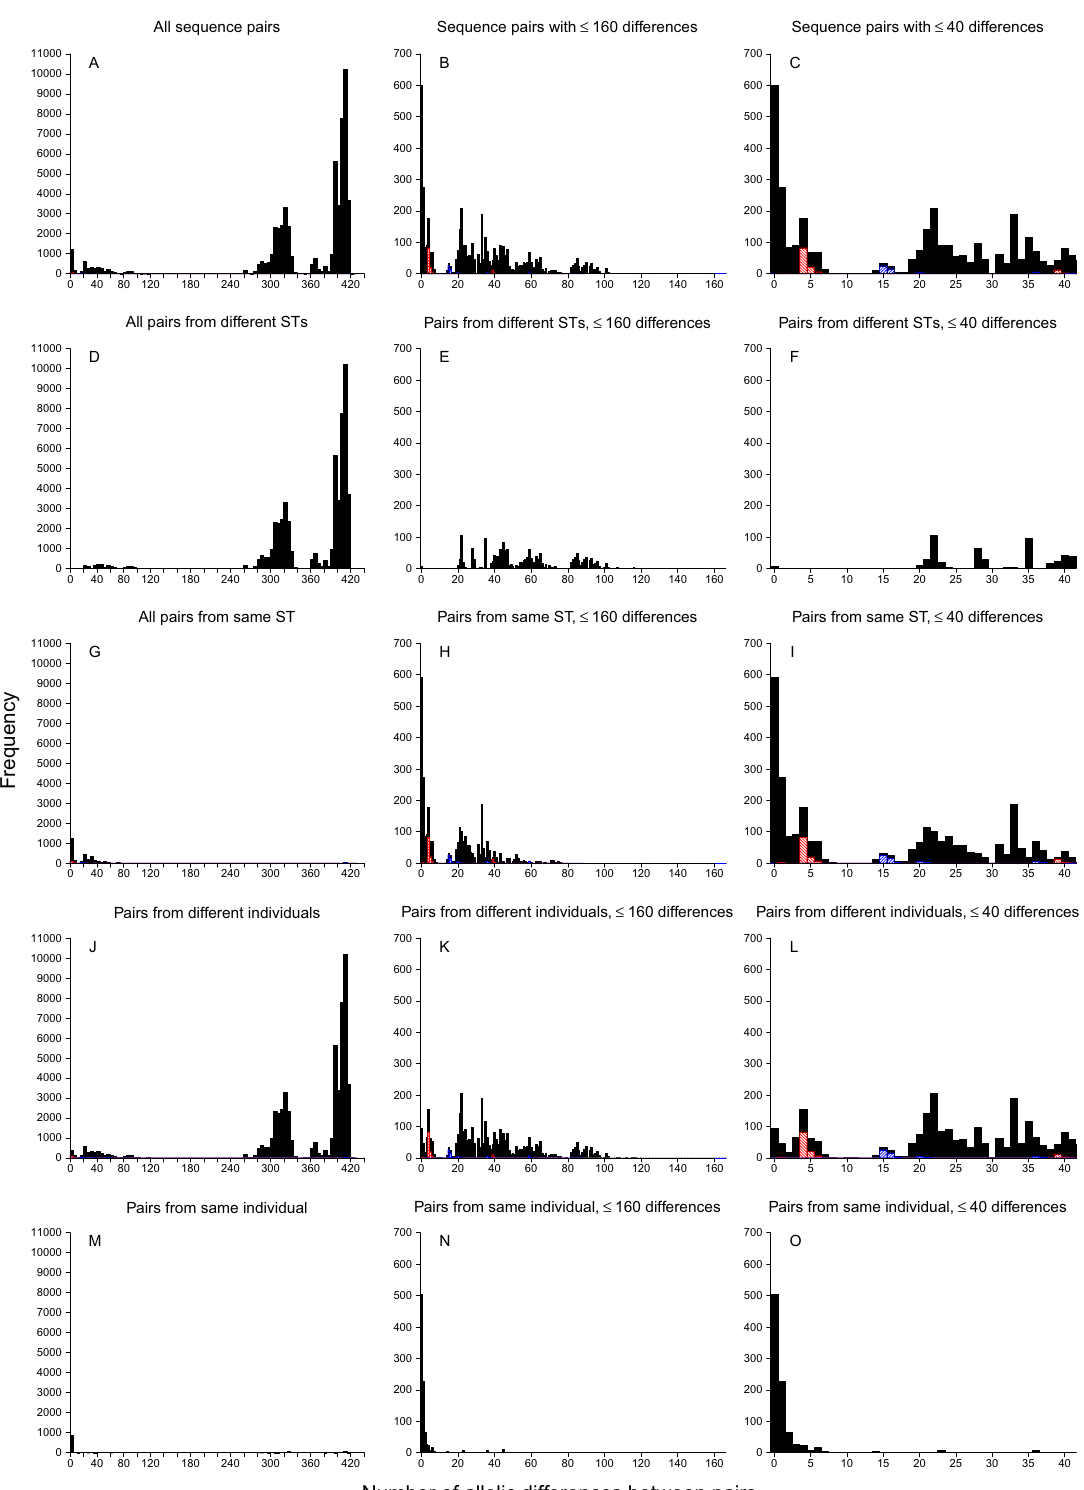
Figure 3. Histograms of allelic differences between sequence pairs. Red hashed bars indicate comparisons of isolates from siblings. Blue hashed bars indicate comparisons of isolates from a child participant and a study staff member (unlikely to represent direct